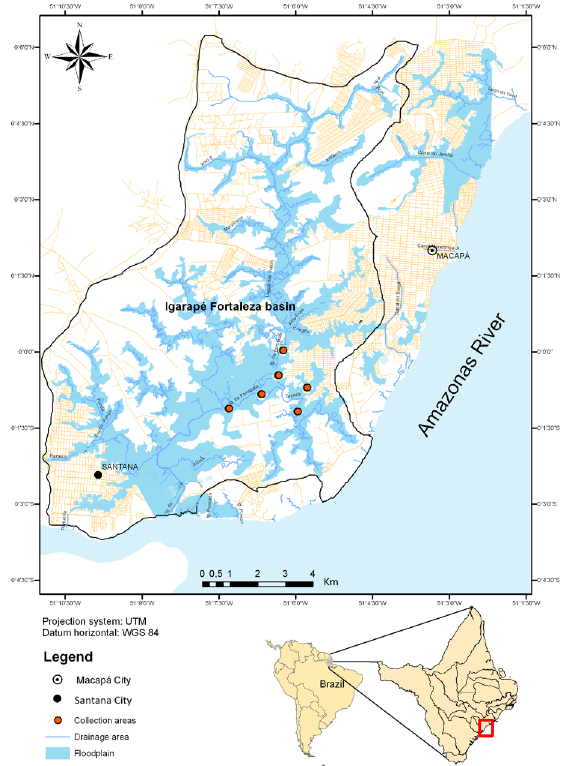
Figure 1 - Collection sites of Astronotus ocellatus from the Fortaleza Igarapé basin, in the eastern Amazon